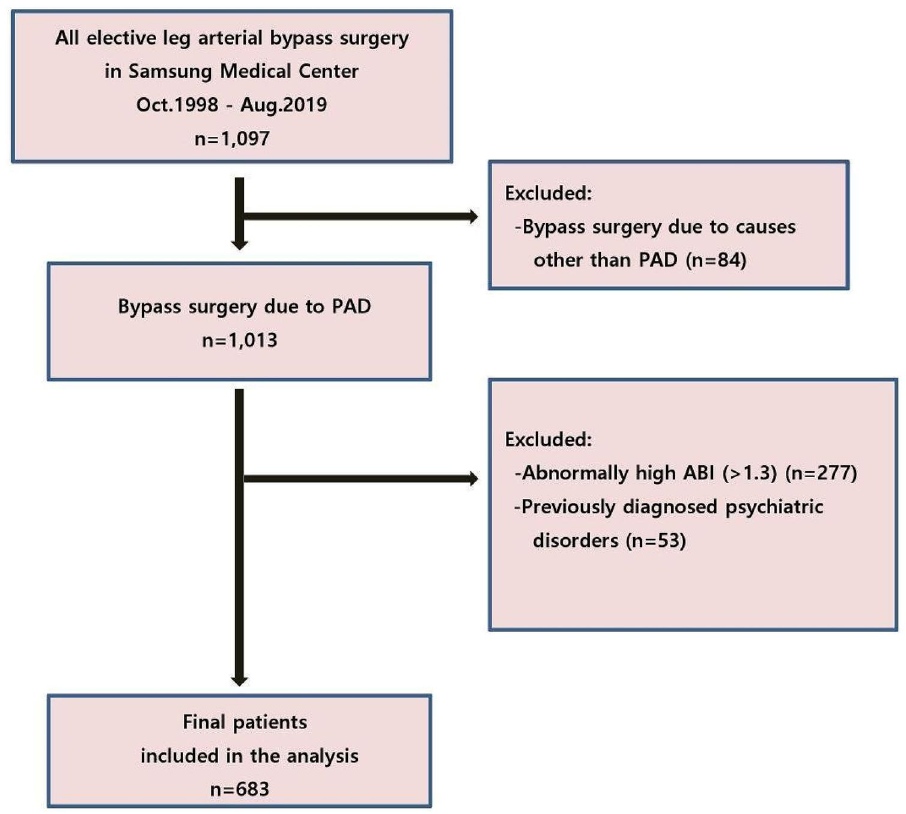
Figure 1. Patient selection flow